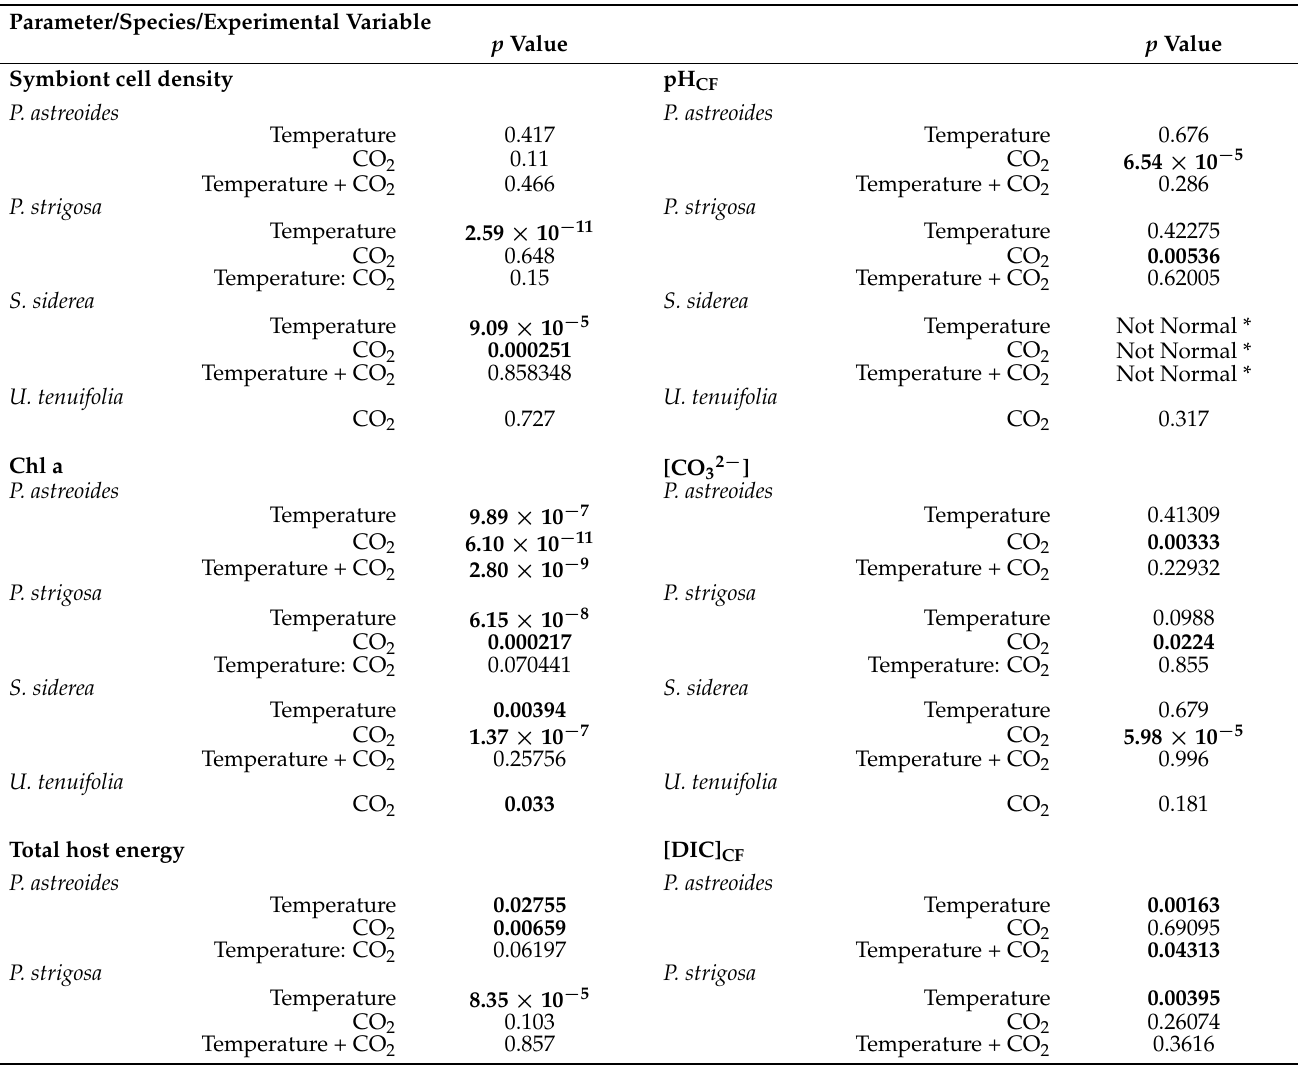
Table 4. 2-way ANOVA output testing the influence of temperature and p CO 2 on calculated calcifying fluid carbonate system parameters and coral and symbiont physiological